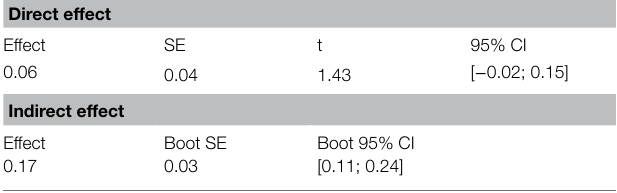
TABLE 3 | Direct and indirect effects of grit on